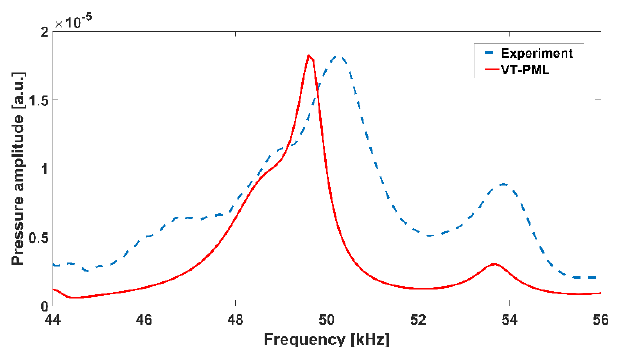
Figure 3. Frequency response of the reference resonator from the viscothermal model with perfectly matched layers (VT-PML) simulation and measurement. The measurement and simulation results are scaled for easier viewing and comparison.